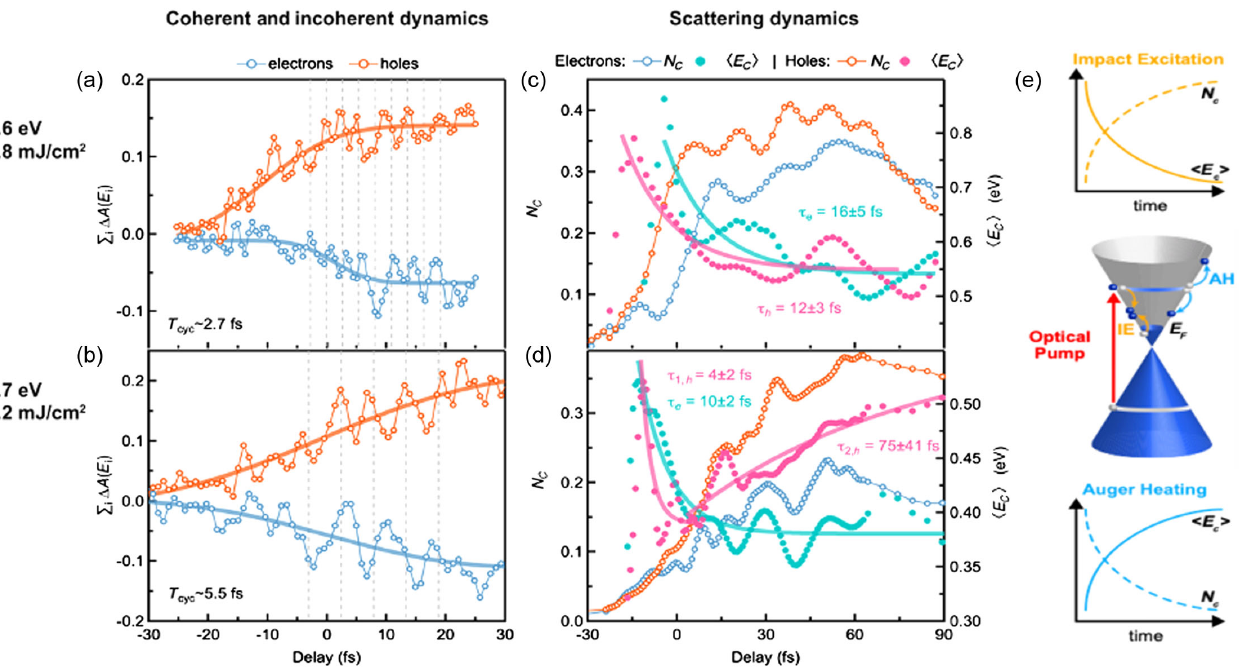
P Δ A , which shows the i (open symbols) and their average kinetic c